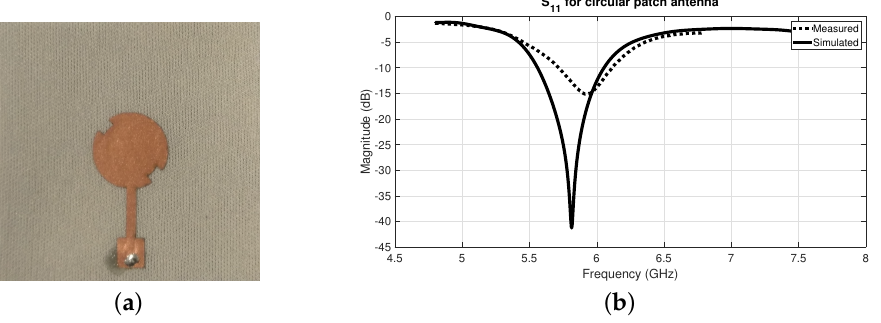
Figure 12. Circular patch textile antenna for 5.8 GHz: ( a ) manufactured antenna and ( b ) S 11 results.